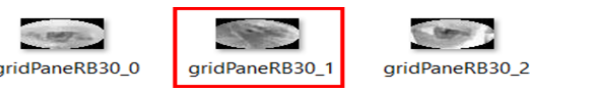
Figure 4. An example of an extra element incorrectly detected as an eye by the